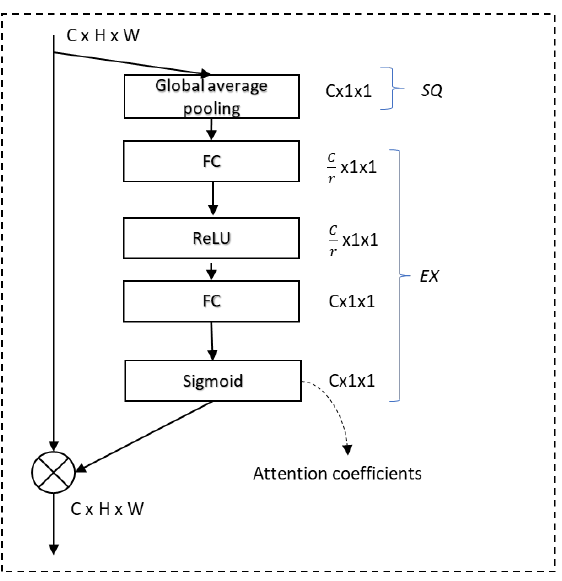
Figure 4. Flow diagram of the squeeze and excitation (SE) module.